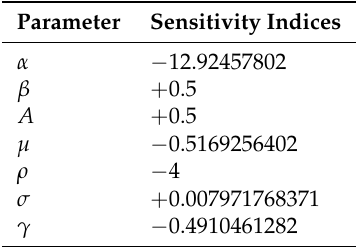
Table 3. Sensitivity analysis of R 0 : β = 10 − 20